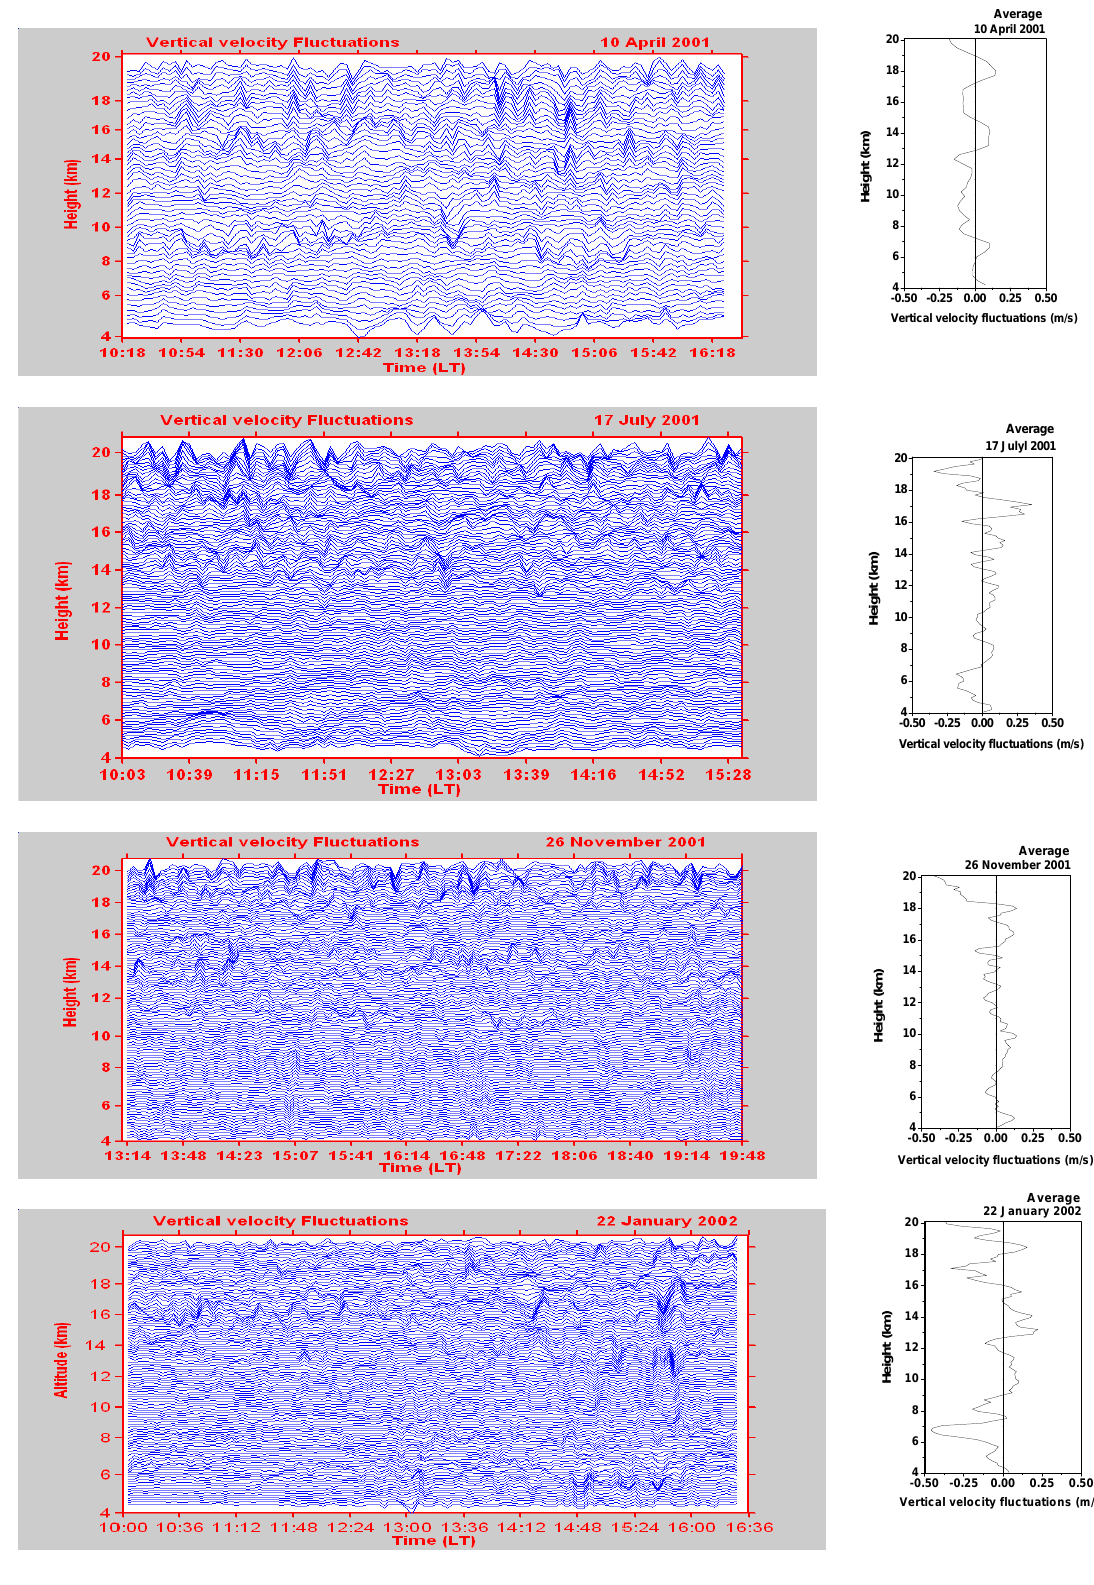
Fig. 5. Fig. 5. Same as Fig. 3, but for the vertical velocity fluctuations obtained by removing the background wind velocity at each height for a typical day, observed 6h with Indian MST Radar during 10 April 2001, 17 July 2001, 26 November 2001, 22 January 2002. Successive profiles are displaced by 0.2m/s, 0.2m/s, 0.2m/s and 0.2m/s,